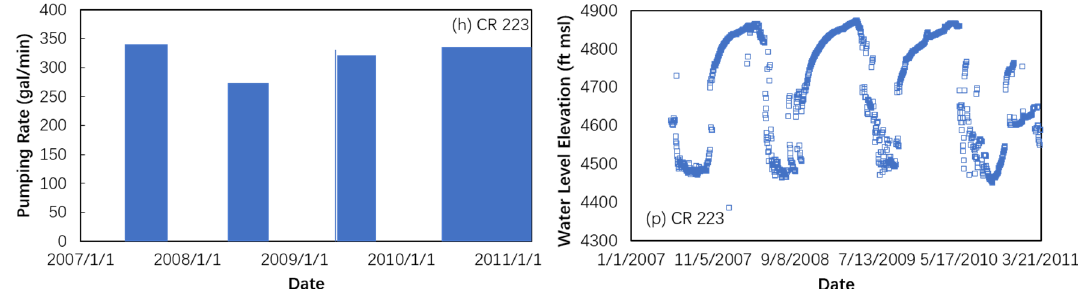
Figure 2. Pumping rates ( a – h ) and water levels ( i – p ) in eight wells at the Meadows Pumping Center, CO.